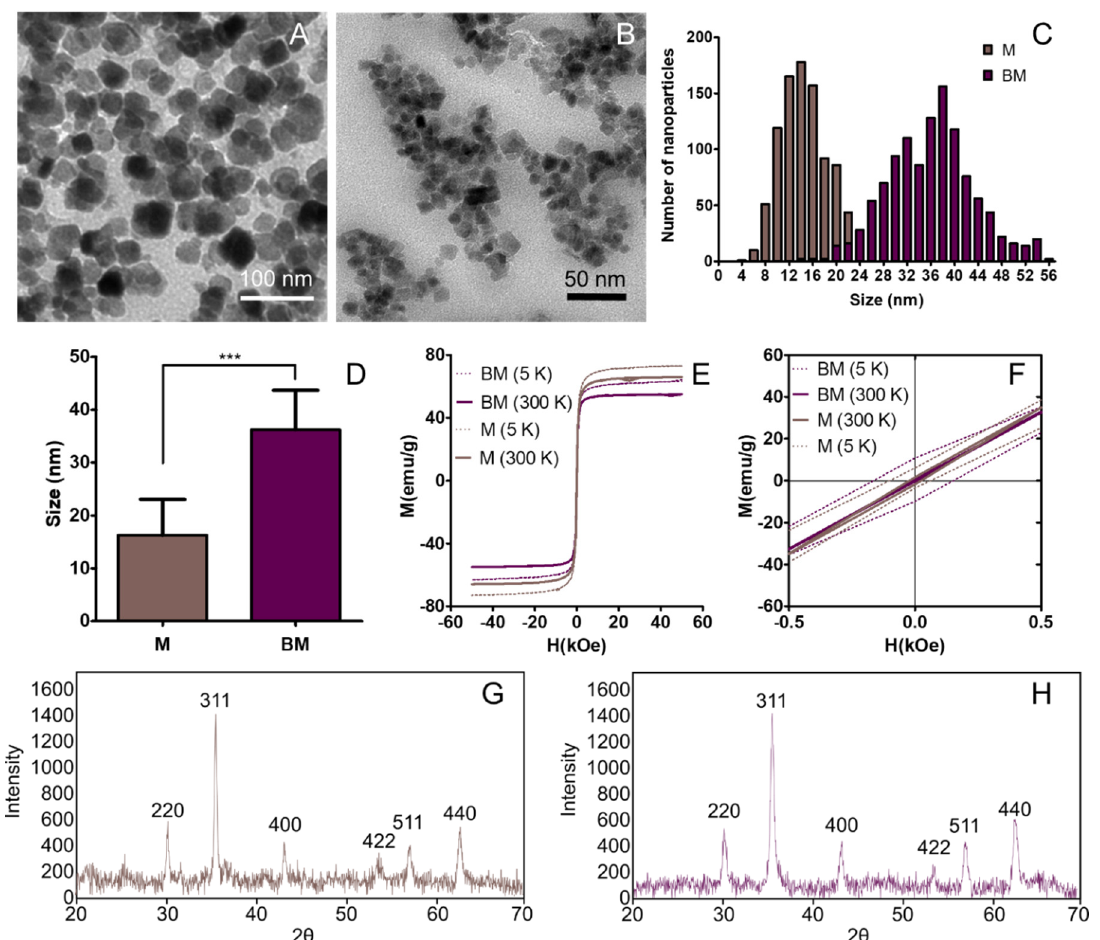
Figure 1. TEM images of biomimetic ( A ) and inorganic ( B ) magnetic nanoparticles. Diameter histograms of biomimetic and inorganic magnetic nanoparticles ( C ). Mean ± standard deviation of nanoparticles size ( D ) p < 0.001 (***). Hysteresis loop of BM and M ( E , F : detail). X-ray diffraction (XRD) of M ( G ) and BM ( H ).